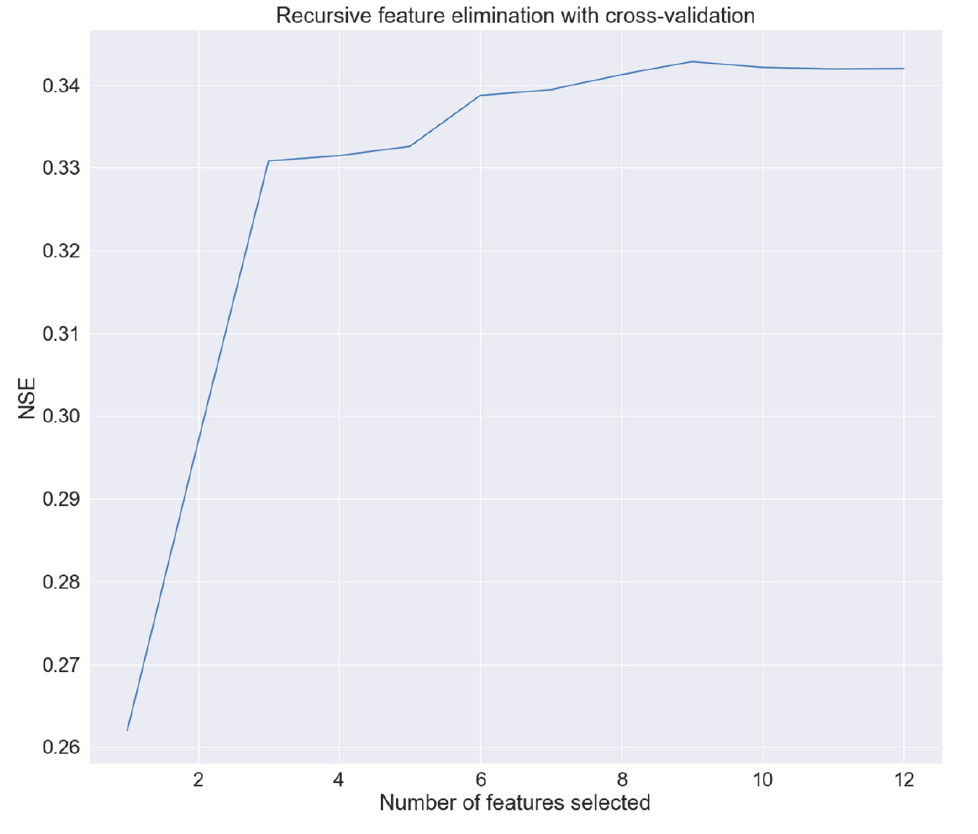
Figure 5. Recursive Feature Elimination performance vs. number of features.